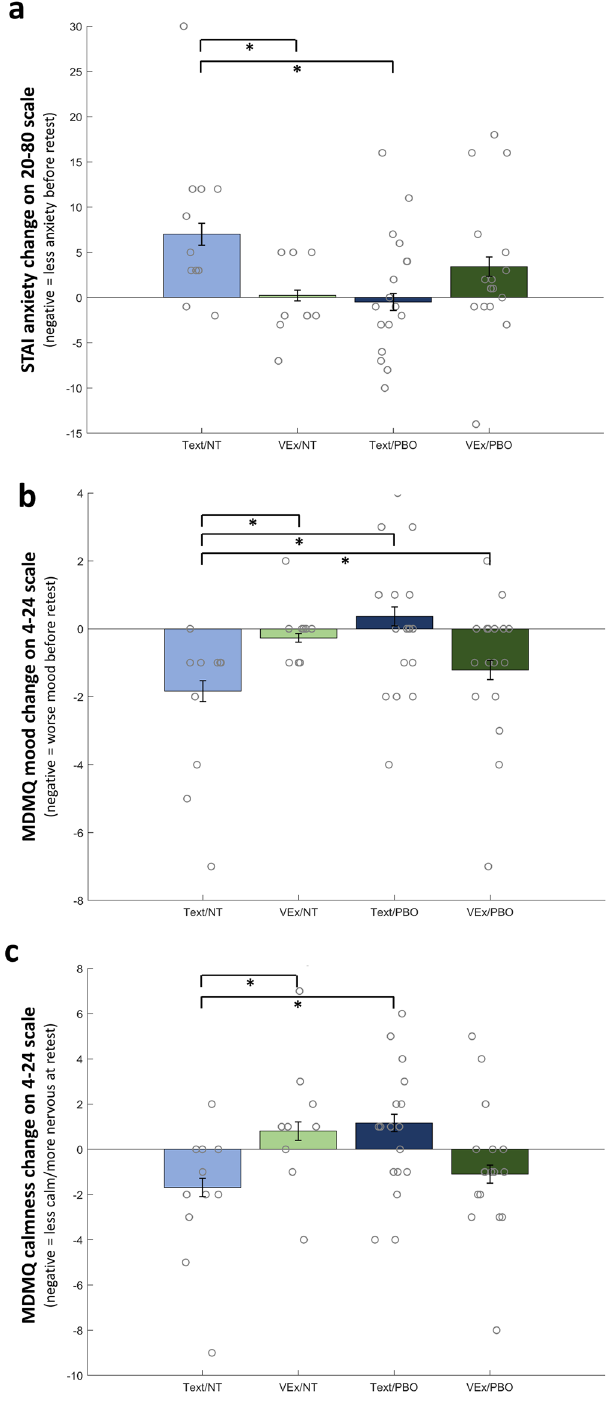
Figure 8. Changes in in psychological states between baseline and retest for the four groups, measured prior to the painful stimulation. Grey circles are single data points (score differences). ( a ) Change in STAI anxiety. ( b ) Change in MDMQ Good/Bad. ( c ) Change in MDMQ